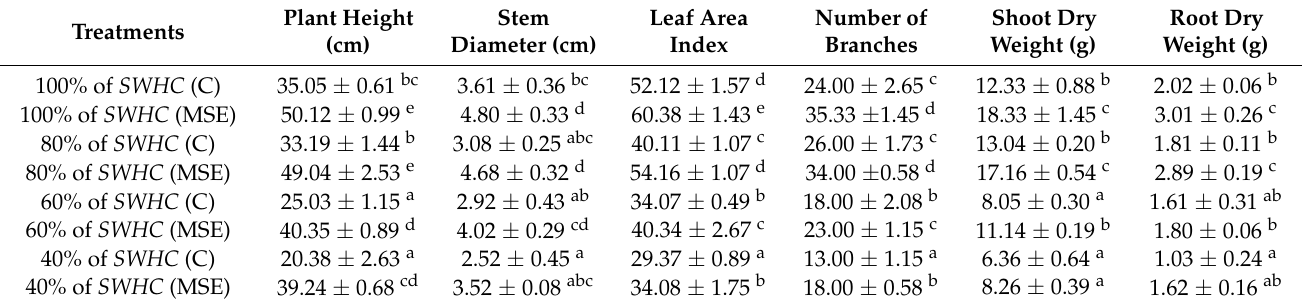
Table 3. Response of growth and yield attributes of S. frutescens to foliar spray application of M. oleifera seed extract under deficit irrigation conditions.